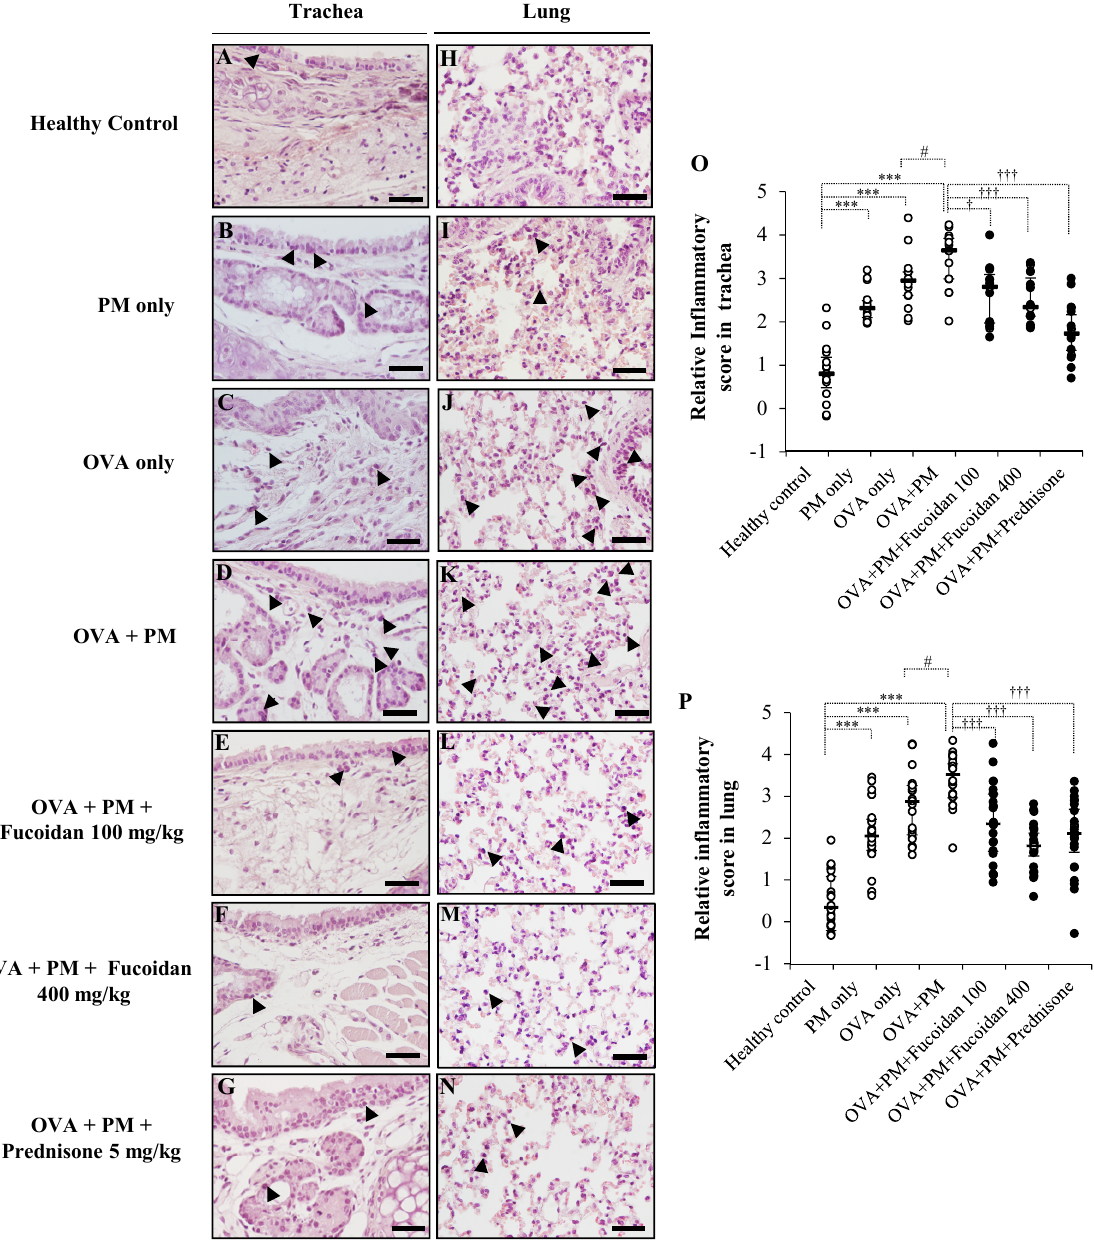
Figure 3. PM-aggravated histological changes in vivo and the e ff ect of fucoidans on them. Representative images of H&E stained ( A – G ) trachea and ( H – N ) lung sections are shown. ( A , H ) Healthy control, ( B , I ) PM only, ( C , J ) OVA only, ( D , K ) OVA + PM, ( E , L ) OVA + PM + Fucoidans (100 mg / Kg), ( F , M ) OVA + PM + Fucoidans (400 mg / Kg), ( G , N ) OVA + PM + Prednisone (5 mg / Kg). The infiltration of inflammatory cells is indicated with arrowheads. Scatter plots showing the median and interquartile range of the inflammatory scores for tracheal sections ( A – G ) are shown in ( O ) and those for lung sections ( H – N ) are shown in ( P ). The degree of peri-bronchial and perivascular inflammation of lung and tracheal sections (at least 6 sections / mice, n = 4) from each group were separately evaluated on a subjective scale as follows: 0, normal; 1, few inflammatory cells infiltrated; 2, infiltration of inflammatory cells one cell layer deep; 3, infiltration of inflammatory cells 2–4 cell layers deep; and 4, a ring of inflammatory cells more than four cell layers deep. The scale bar of ( A – N ) is 25 µ m). We added random jitter in the vertical direction to avoid overlapping data points. The error bars represent the interquartile range and median. *** ( p < 0.0005) represents a significant increase compared with the healthy control, and † ( p < 0.05), ††† ( p < 0.0005) represents a significant decrease compared with the OVA + PM group. # represents a significant increase compared to OVA